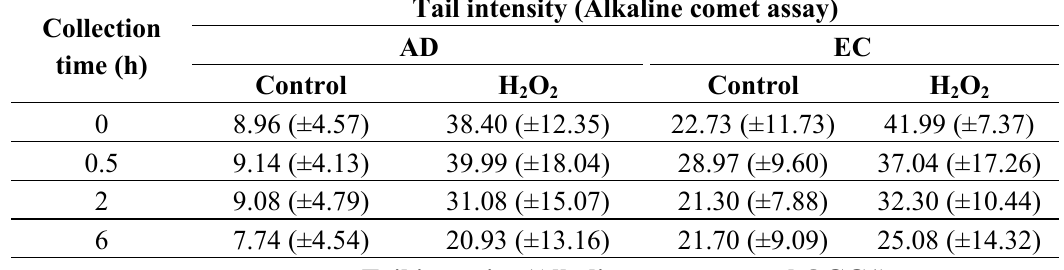
O during the last 60 min and harvested 2 2